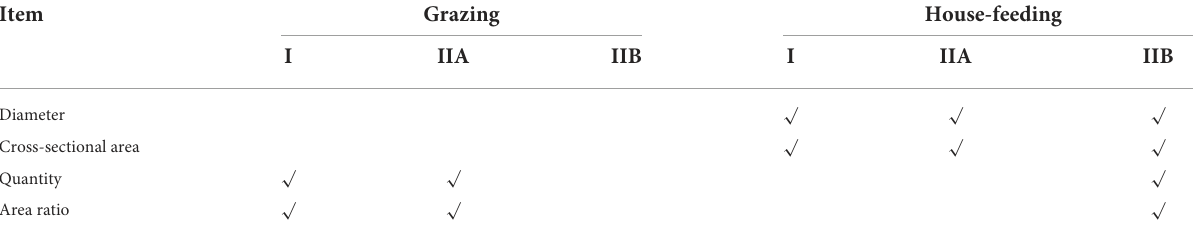
TABLE 3 Effects of feeding regimes on muscle fiber types of Longissimus thoracis of Sunit sheep